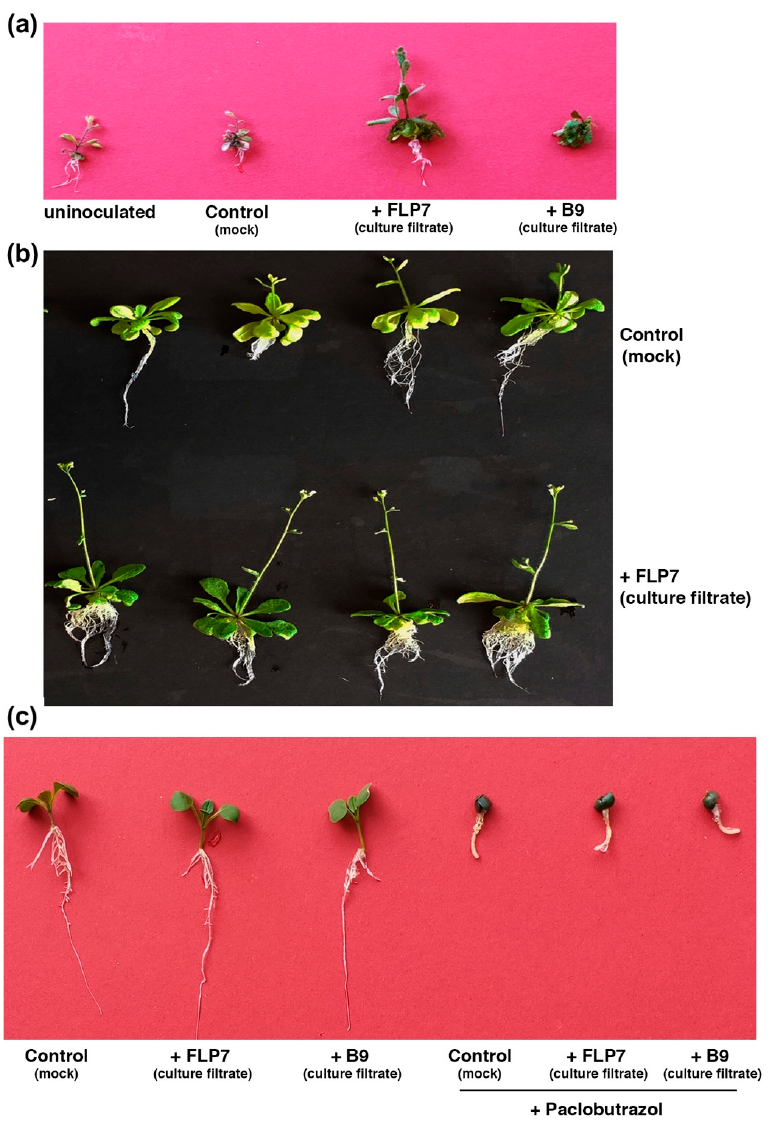
Figure 6. The effect of P. citrinum on the growth of Arabidopsis ga1 mutant and wild-type accession Col-0. ( a ) The morphological traits of Arabidopsis ga1 mutant in the presence or absence of exudates from beneficial P. citrinum cultures (B9 and FLP7) grown in a complete medium. ( b ) Wild-type Arabidopsis Col-0 treated with the culture filtrate from P. citrinum . Control refers to the mock inoculation with equivalent amount of growth medium without the fungus. ( c ) Gibberellin(s) produced by P. citrinum contribute in part to growth promotion in Choy Sum. The culture filtrate from the indicated P. citrinum isolate grown in a complete medium in the presence or absence of Paclobutrazol (the gibberellin biosynthesis inhibitor) was inoculated on Choy Sum seeds. Control refers to mock inoculation with the sterile growth medium in the absence of the